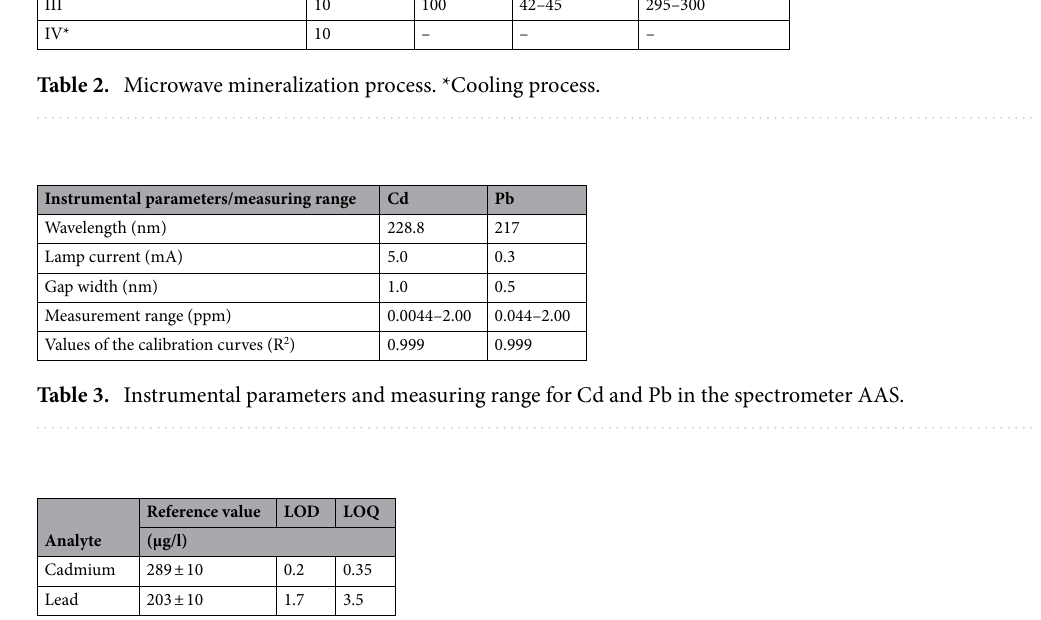
Table 4. Certified values of Certified Reference Materials (CRMs—TYG006RM) and LOD/ LOQ